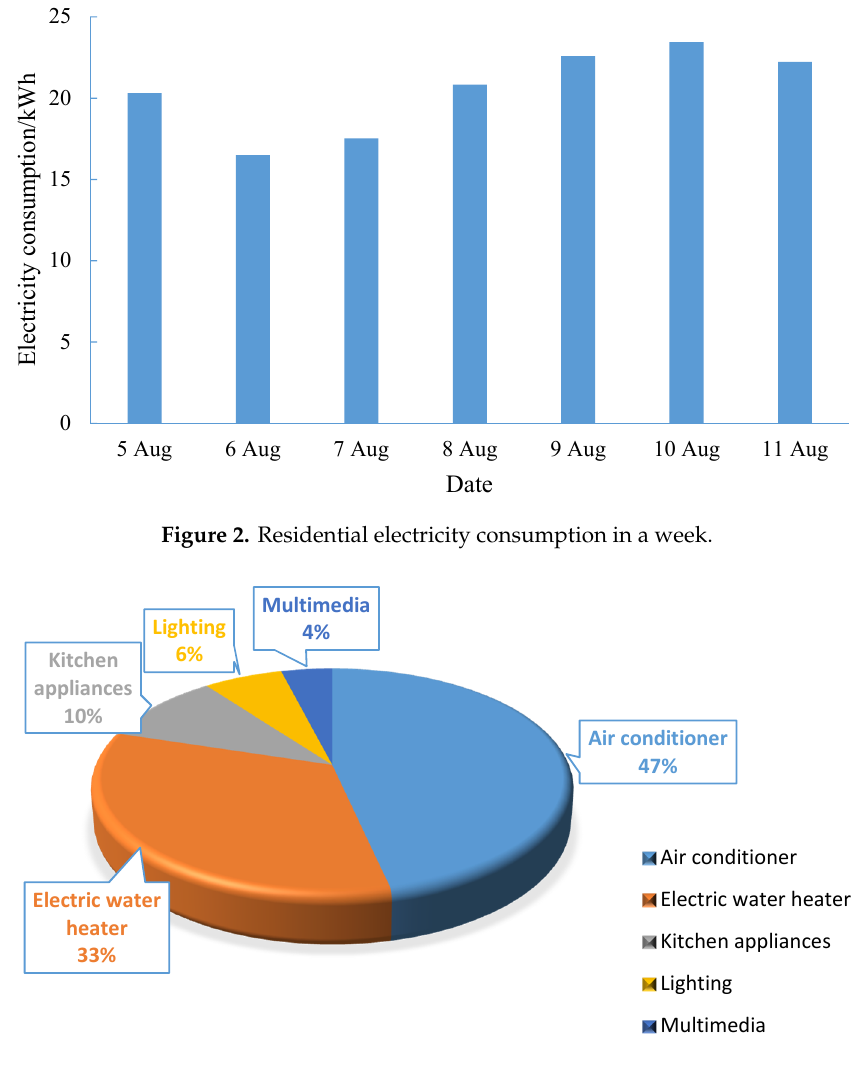
Figure 3. Household electricity composition analysis.